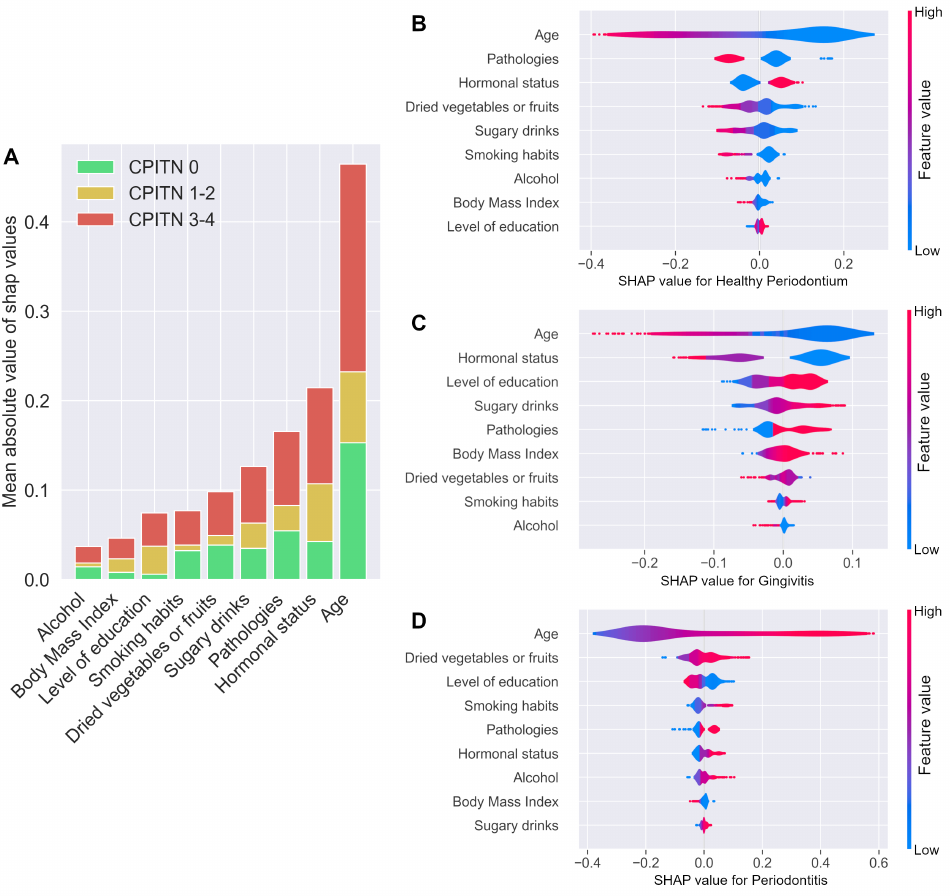
Figure 4. Explanations of the ML model. The “KernelSHAP method” was used for prediction, assigning each attribute (i.e., each variable of the final ML model) with an importance value (SHAP value) for the prediction of specific CPITN scores. ( A ) Variable importance for each CPITN score, sorted by decreasing mean absolute values of SHAP values. SHAP values, according to feature values for subjects with healthy periodontium ( B ), gingival inflammation ( C ), or periodontitis ( D ). The color of each violin plot encodes the value of the associated variable—red for higher values for the variable and blue for lower values. For the categorical variables, a low value can also signify a missing value. For hormonal status, the values in increasing order were as follows: being a man, non–menopausal woman, postmenopausal woman. On the x–axis, a positive SHAP value signifies that the variable, contributes positively to the risk prediction, whereas a negative SHAP value signifies that the variable contributes negatively to the prediction. Variables are shown from the top to the bottom, in order of importance (mean of absolute SHAP